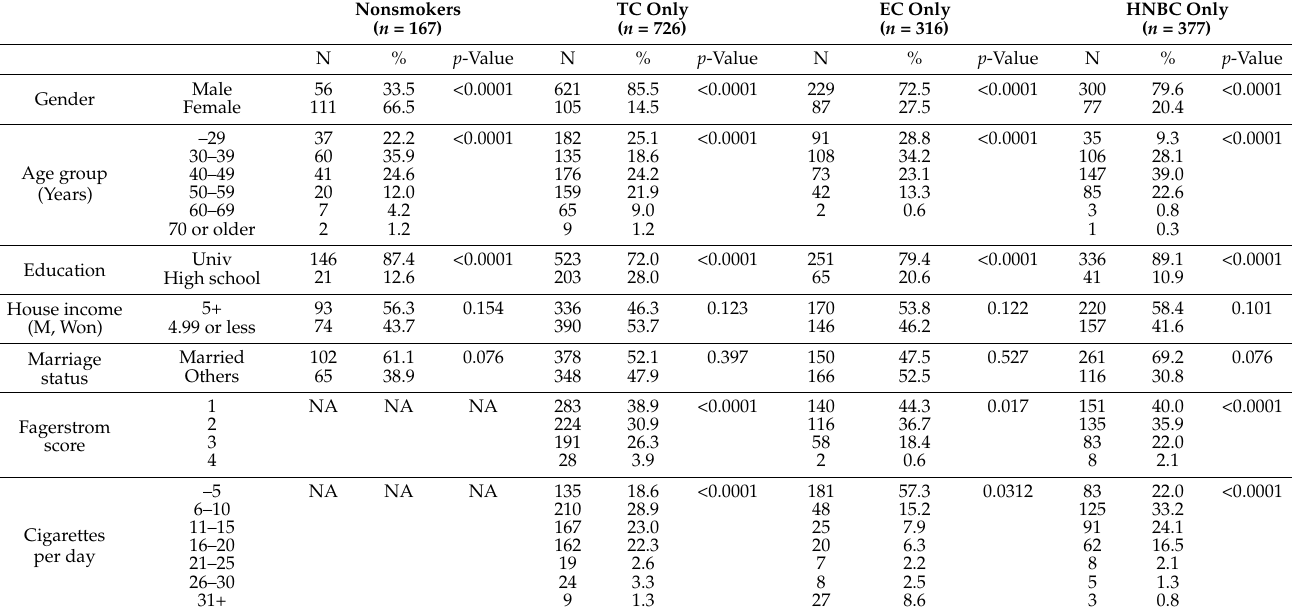
Table 1. Proportion of study subjects according to age, household income, education level, residential area, marital status, smoking status, and Fagerström nicotine addiction